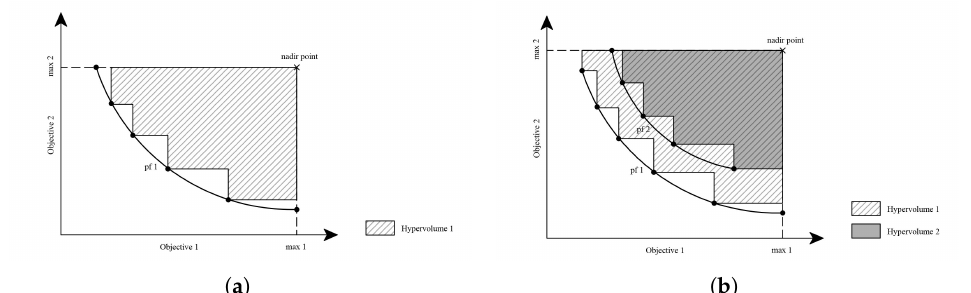
Figure 1. Examples of the calculation of the hypervolume indicator in a bi-objective minimization problem for one ( a ) and two ( b ) Pareto